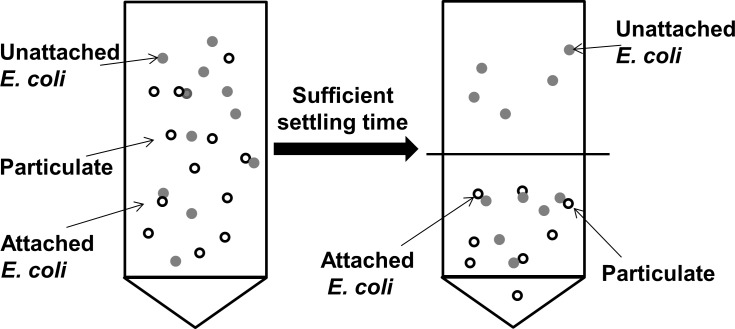
Attachment assay depiction.The concentration difference between the remaining suspension (Cr) and the supernatant (Cs) was considered the attached E. coli concentration.